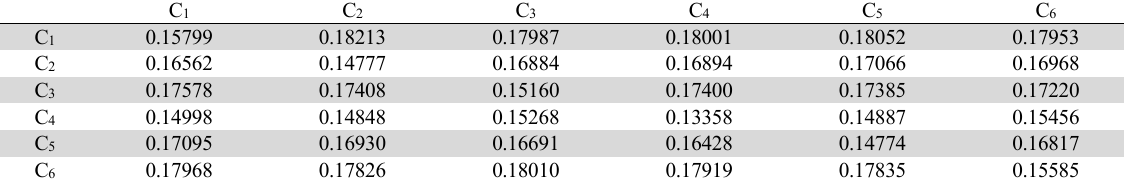
Normalized diaphragmatic relationships matrix